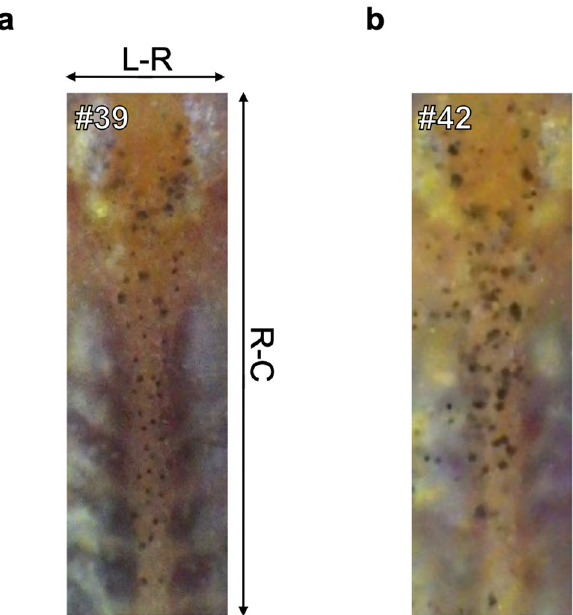
Figure 5. Extended views of melanophore spot distribution patterns on the dorsal side. Distribution patterns from the mesencephalic to the mid spinal cord region of Individual #39 ( a ) and #42 ( b ) in Fig. 4b are shown. The mesencephalic regions of the patterns are the same as Fig. 4b #39 and #42. R–C: rostral-caudal axis, L-R: left–right